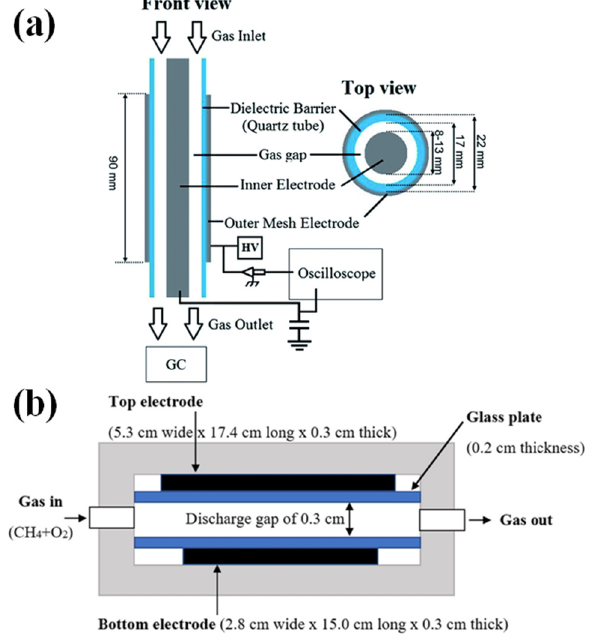
Figure 2. DBD plasma reactor: ( a ) Coaxial tube. Reprinted with permission from [38]. Copyright 2015 The Royal Society of Chemistry. ( b ) Plate-to-plate. Reprinted with permission from [45]. Copyright 2020 Springer.